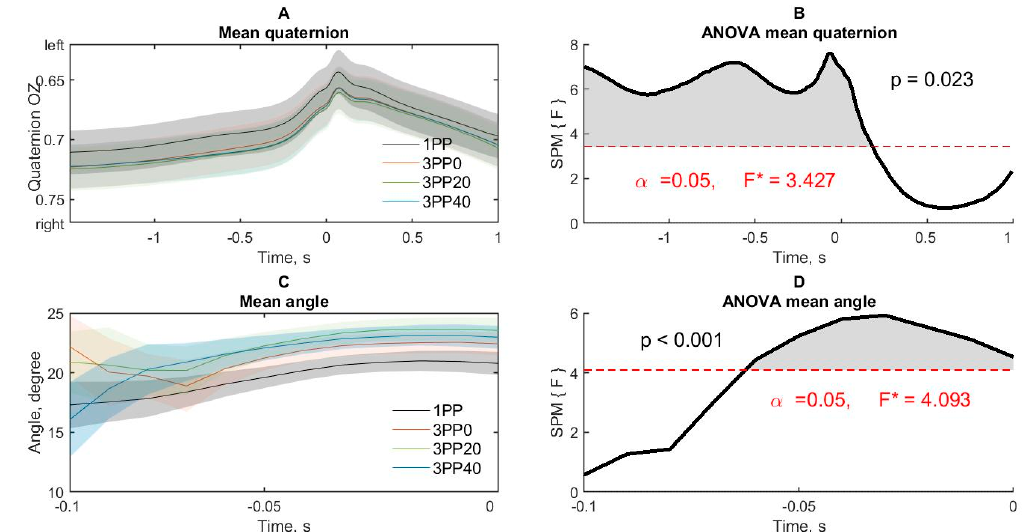
Figure 6. The angle data of torso rotation and hand movement during the dart throwing. ( A ) Torso rotation angle on the OZ axis in four conditions of throws. Semi-transparent areas around lines are standard error of mean. ( B ) ANOVA e ff ect of the condition on the rotation angle of the torso. Red dashed lines mark the statistically significant level (with FWER correction). ( C ) Direction of the right hand movement in four conditions of throws. ( D ) ANOVA e ff ect of the condition on degree of direction of movement of the right hand. Red dashed lines mark the statistically significant level (with FWER correction). 1PP—first person condition, 3PP0—third-person perspectives with 0 ◦ , 3PP20—third-person perspective with 20 ◦ and 3PP40—third-person perspective with 40 ◦ . Time 0 represents the moment of peak velocity of the right hand moving along the OY axis (along the direction of the